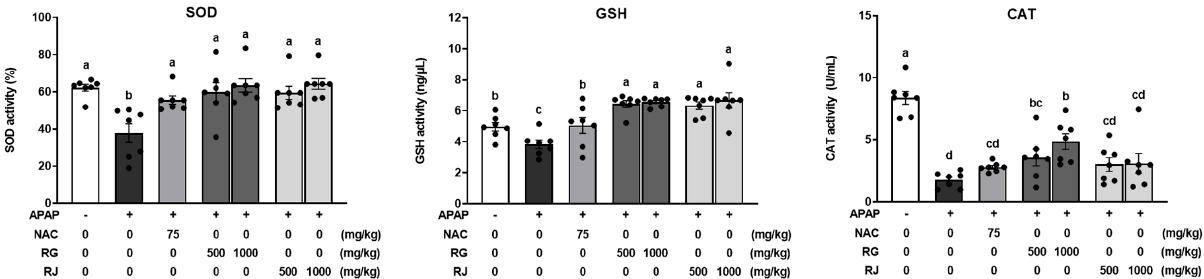
Figure 4. Effects of radish extracts on plasma antioxidant enzymes and glutathione production in the APAP-induced liver-damaged mice. Superoxide dismutase (SOD), glutathione (GSH), and catalase (CAT) levels were measured by ELISA kit. Results are presented as means ± SE. Different letters represent groups significantly different from each other using ANOVA at p < 0.05 ( n = 7). Each dot indicates data measurement for one mouse. CTRL, control; NAC, N-acetyl cysteine; RG, turnips of Ganghwa; RJ, radishes of Jeju.